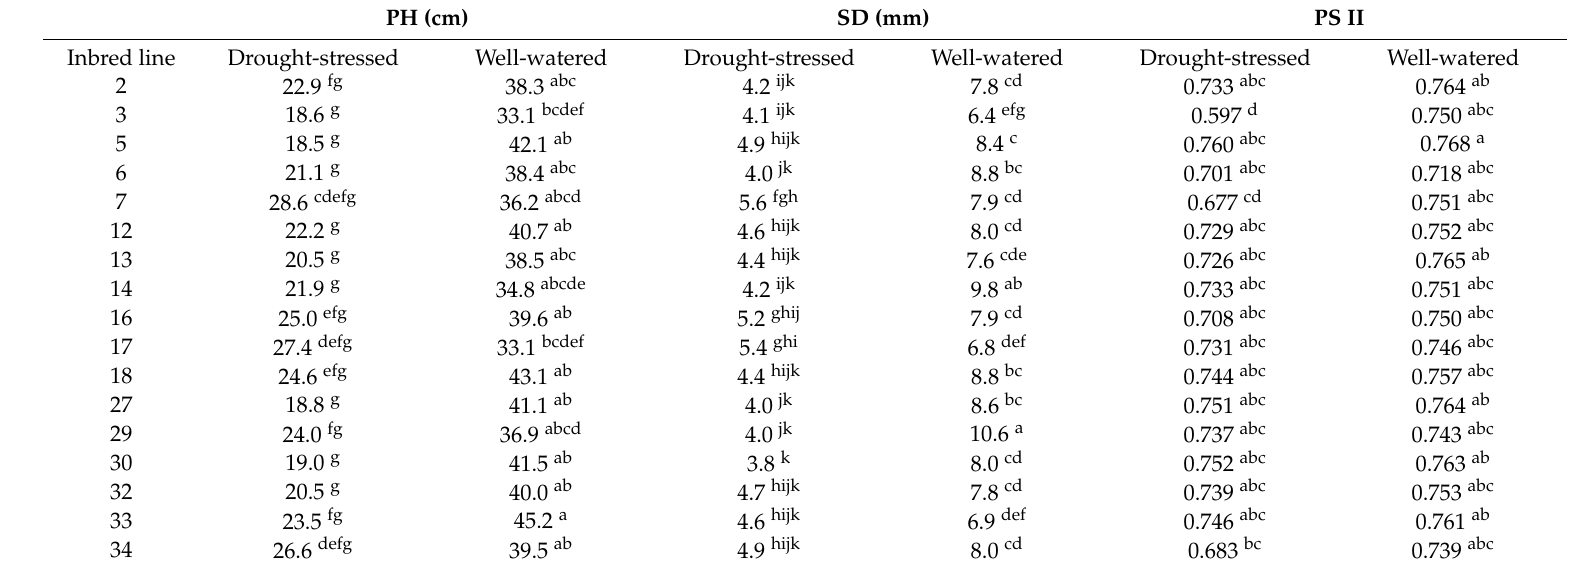
Table 2. Mean comparison among quality protein maize inbred lines based on plant height, stem diameter and photochemical efficiency of photosystem II under drought-stressed and well-watered